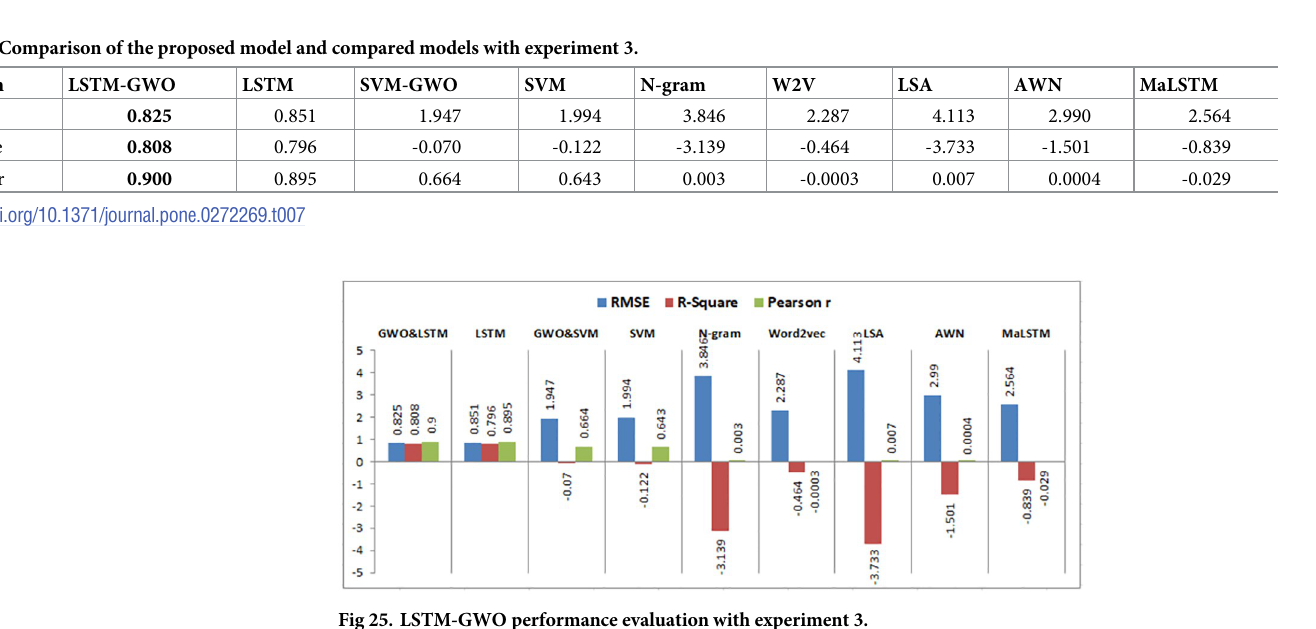
Fig 24, the best results were achieved by the proposed LSTM-GWO model, while the worst results were achieved by the LSA model. Table 7 introduces the comparison results of the proposed model with compared models in auto-grading over 15050 short answers. As shown in Table 7, the proposed model achieved the best results, while the LSA model achieved the worst results. When using the dataset of 15050 answers, Fig 25 shows the suggested LSTM-GWO model performance compared to other models. Table 8 shows the auto-grading outcomes of the proposed model versus the compared models over 4322 short answers.